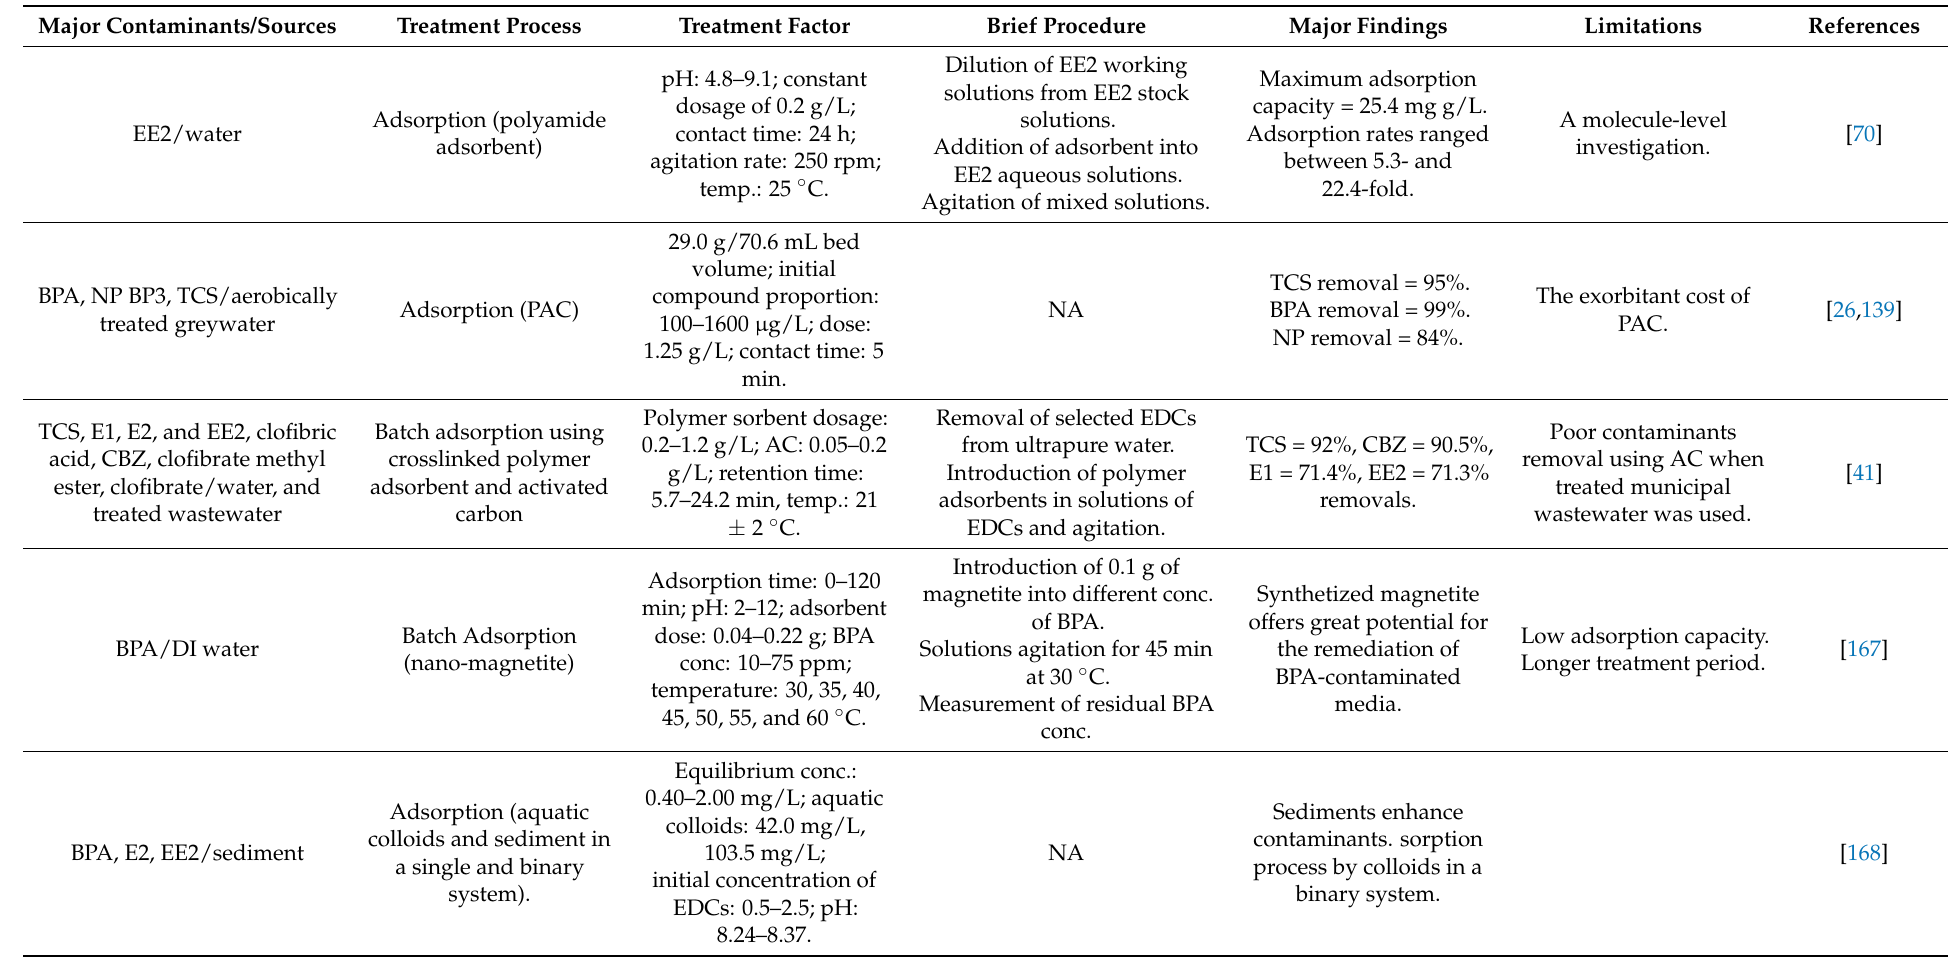
Table 6. Removals of some EDCs during the adsorption